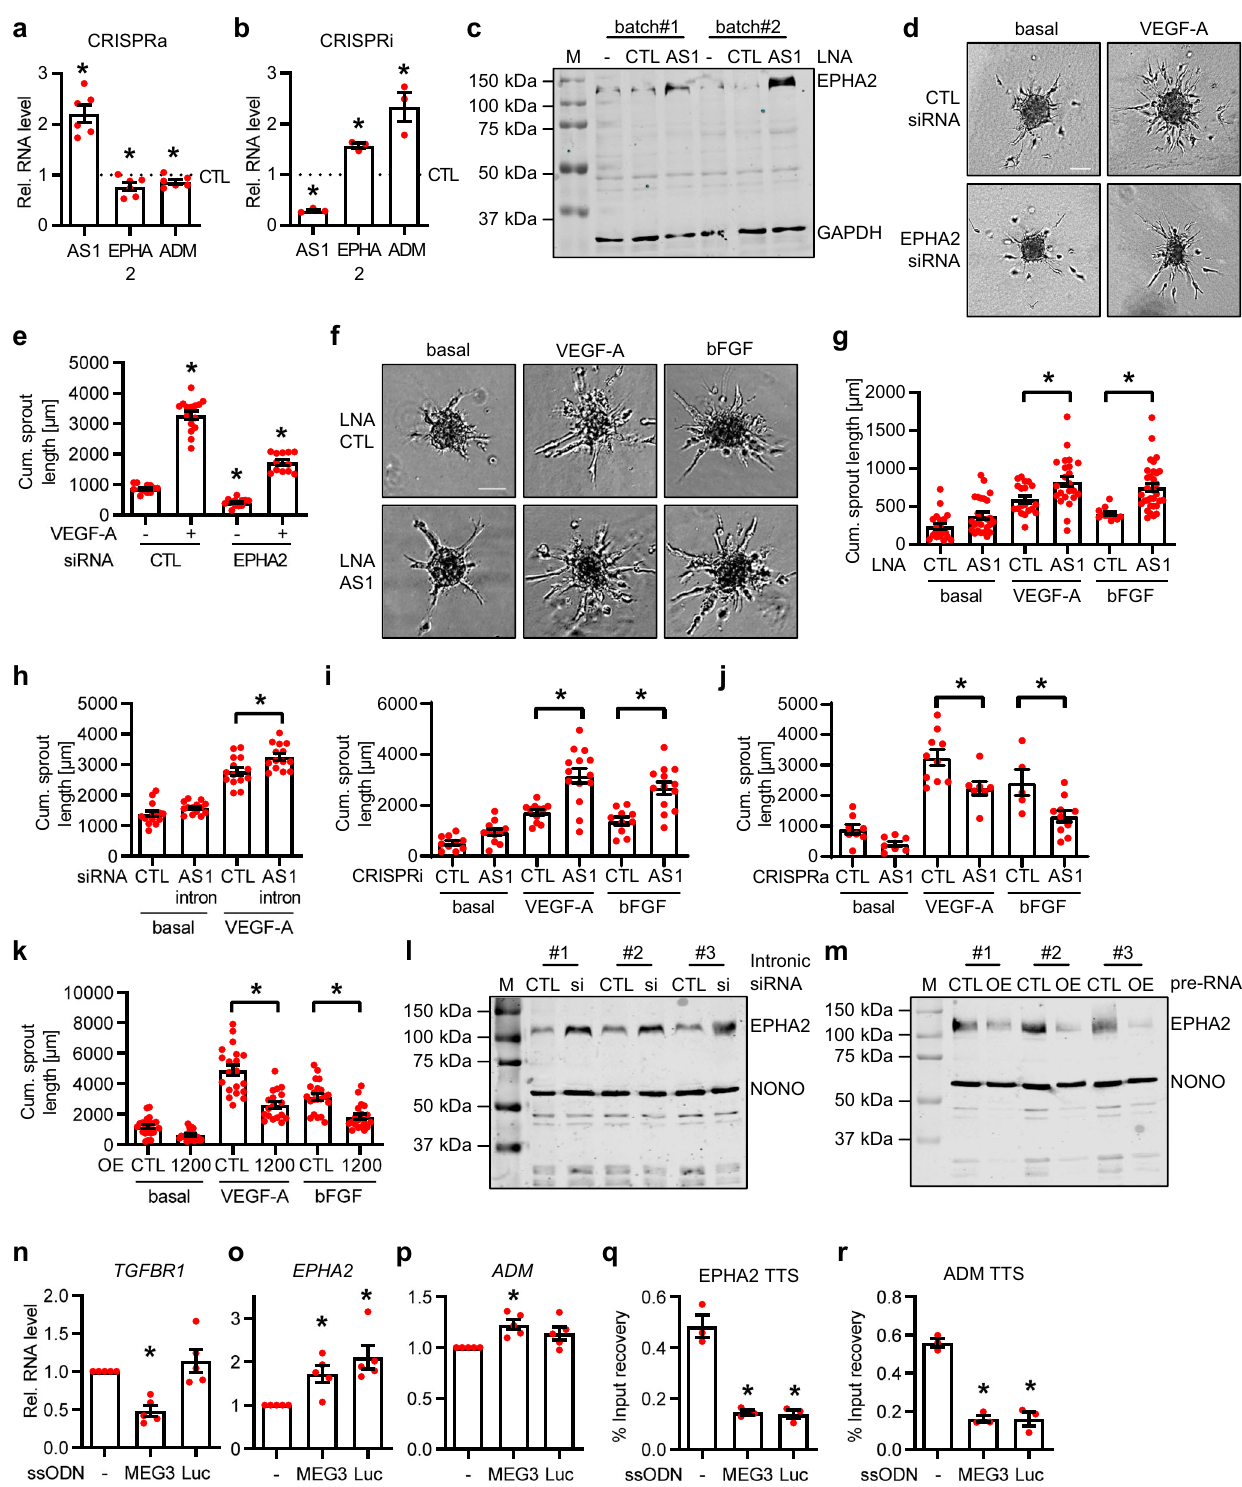
endothelial cells. Proximity ligation assays with antibodies against MPP8, dsDNA, H3K9me3 and SETDB1 con fi rmed the association of MPP8 with dsDNA (Supplementary Fig. 5d), H3K9me3 (Fig. 5i) and SETDB1 (Fig. 5j) in the nuclei of endothelial cells, indicating that parts of the complex are present at endothelial